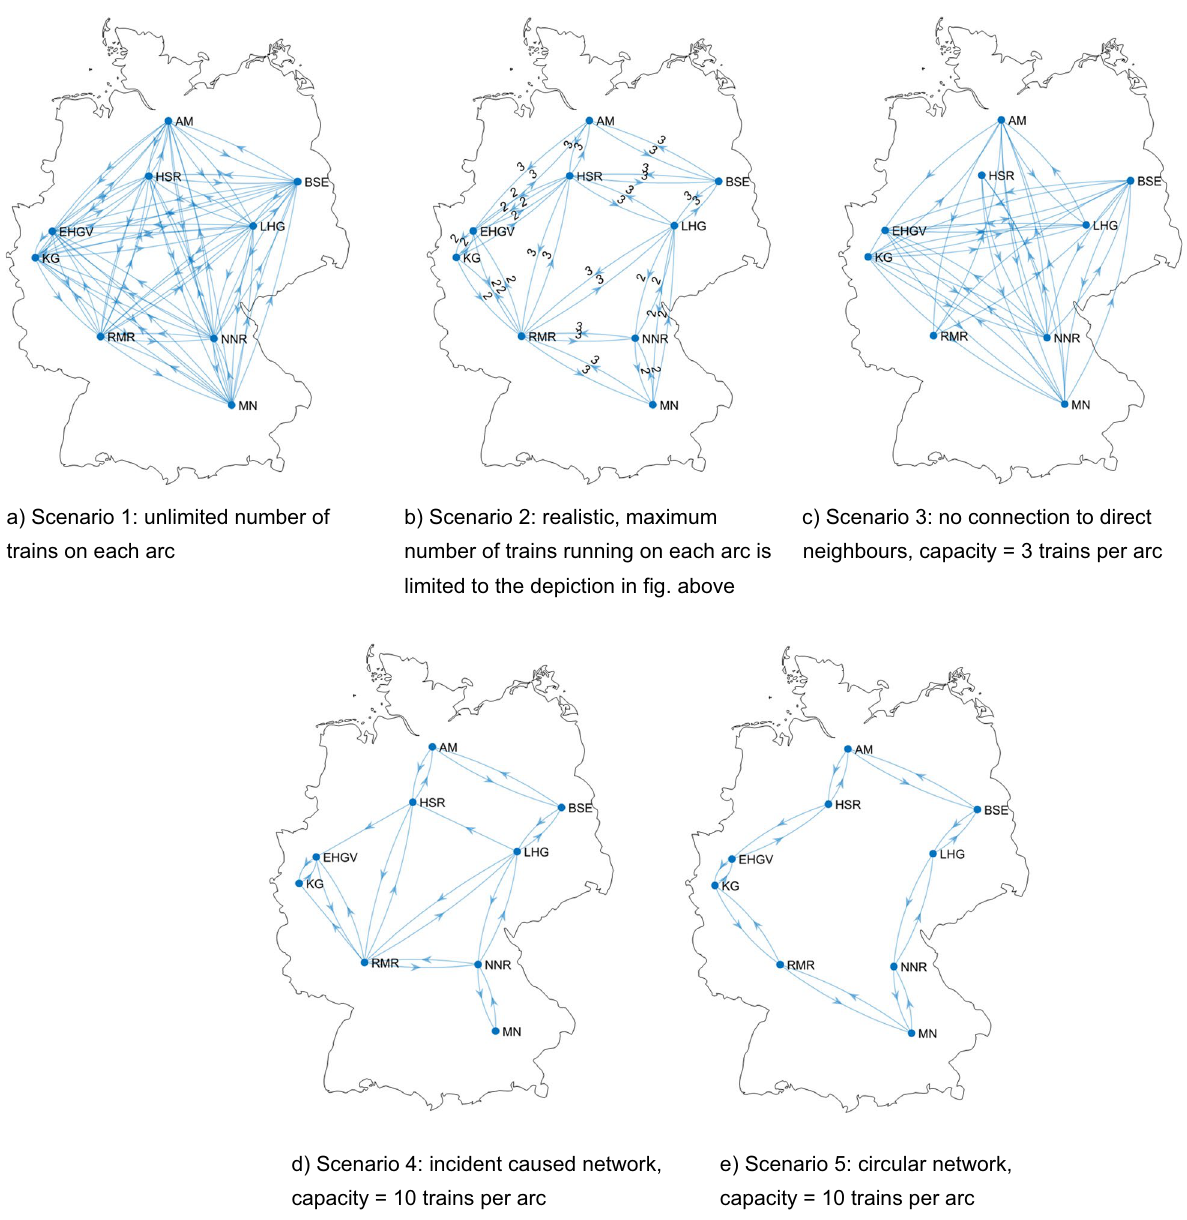
Fig. 1 Network of each Scenario. The coordinates of the marshalling yards were determined by an artificially created coordinate system that encloses Germany. The relative distances in kilometres thus correspond to the actual distances, whereby the curvature of the earth is